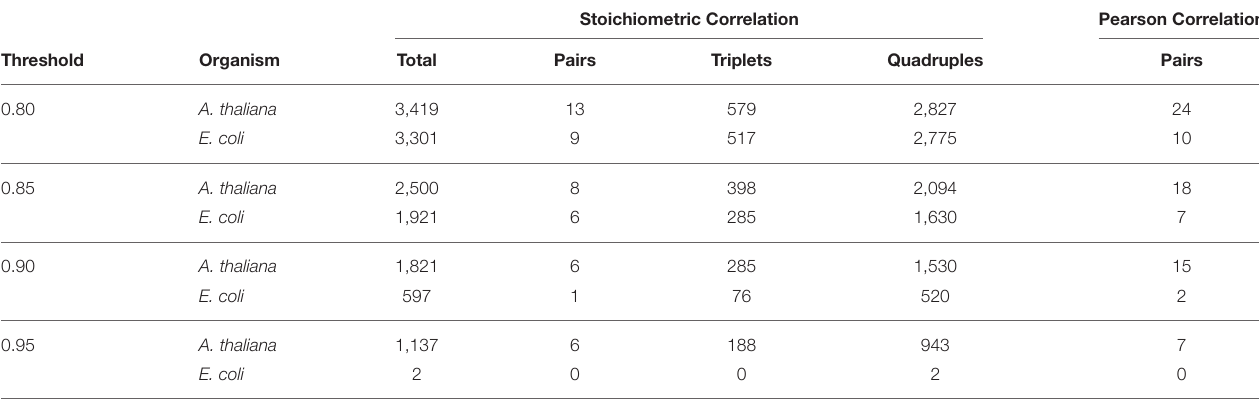
TABLE 1 | Overview of the number of significant stoichiometric correlations at the considered thresholds for metabolic profiles of the stringent response in E. coli and A. thaliana . Stoichiometric Correlation Pearson